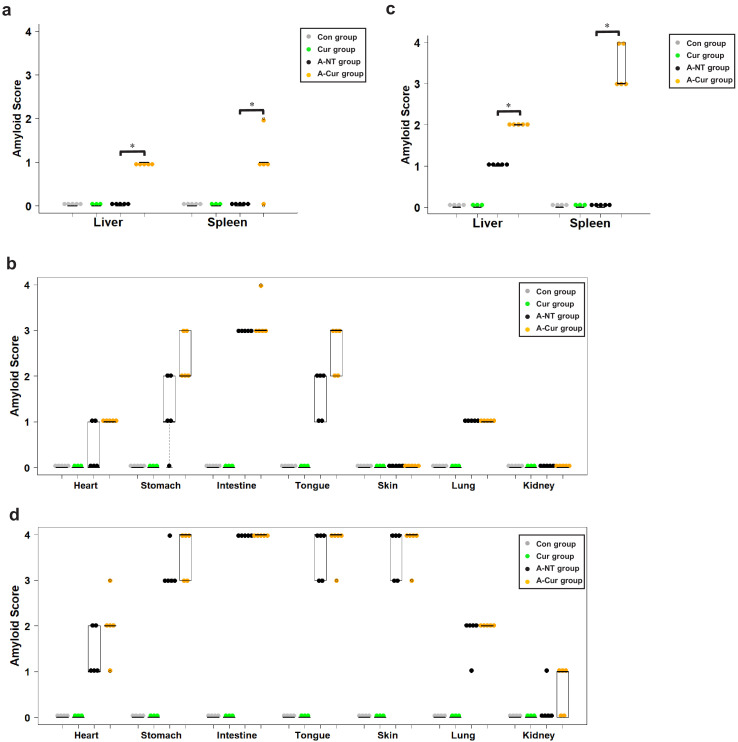
Amyloid score in various organs.(a) Amyloid deposition in the liver and spleen is increased by supplementation with curcumin for 8 weeks. (b) Amyloid score in other organs (heart, stomach, intestine, tongue, skin, lung, and kidney) in the 8-week group. (c) Amyloid deposition in the liver and spleen is increased by supplementation with curcumin for 12 weeks. (d) Amyloid score in other organs (heart, stomach, intestine, tongue, skin, lung, and kidney) in the 12-week group. Each dot represents an individual mouse. The Kruskal–Wallis test with the Steel–Dwass test was used for comparisons of the amyloid score; *p < 0.05.